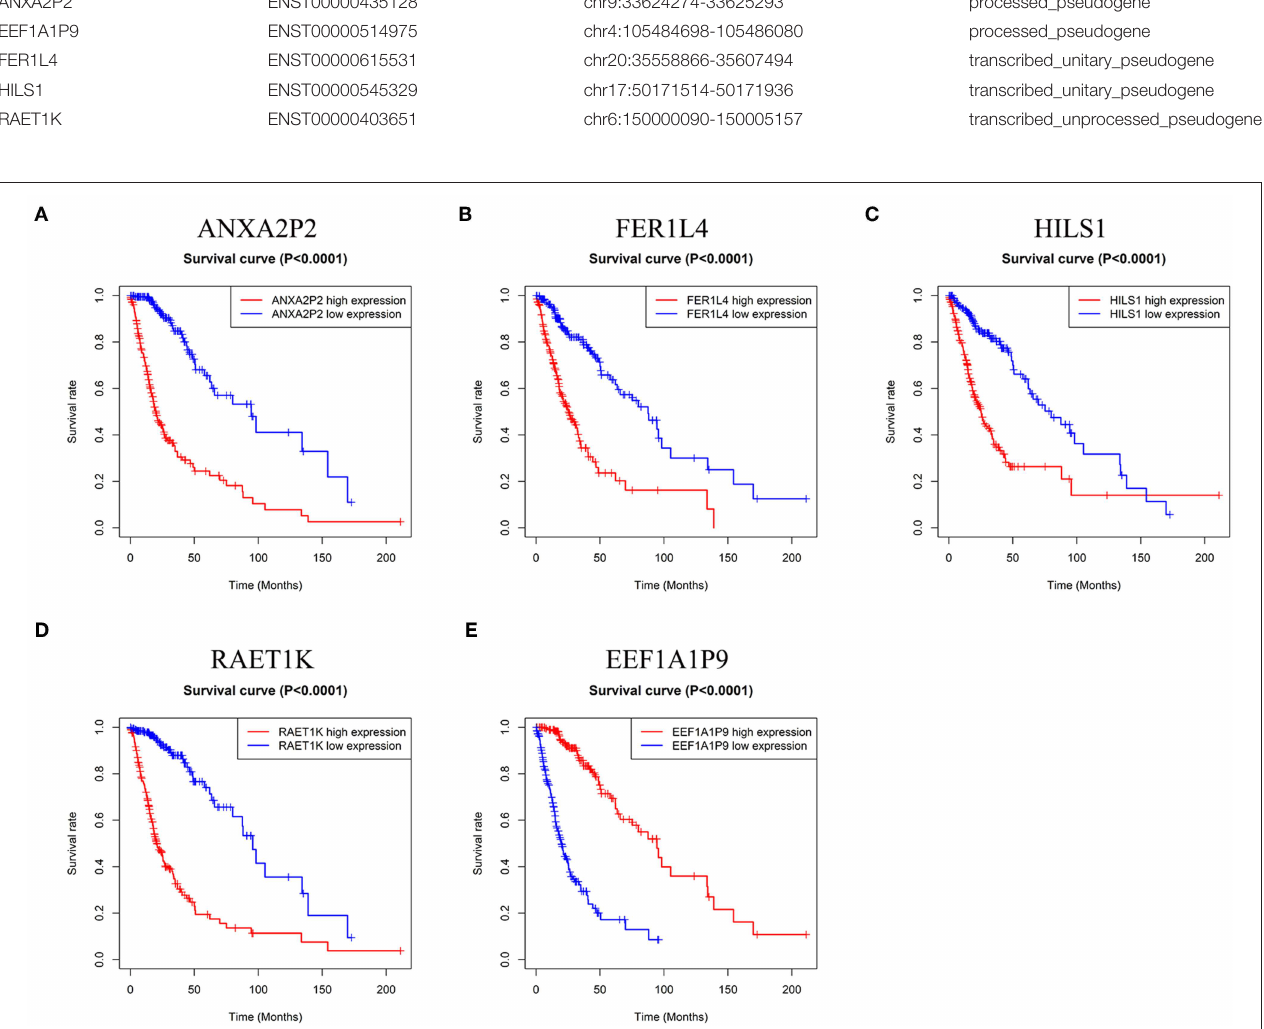
FIGURE 2 | Kaplan-Meier survival curves for the five pseudogenes in glioma. (A–D) High expression level of ANXA2P2, FER1L4, HILS1, and RAET1K indicated poorer prognosis in glioma patients ( P < 0.0001). (E) Glioma patients with higher expression level of EEF1A1P9 had favorable prognosis ( P <